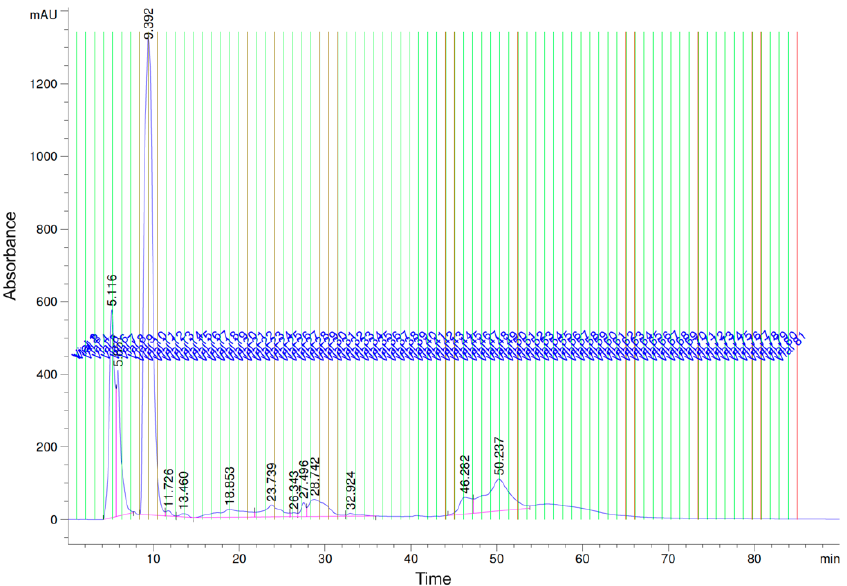
Figure 1. Saliva was collected from female Ae. aegypti after blood feeding. Mosquito saliva was fractionated by high-performance liquid chromatography (HPLC) on a nonporous reverse-phase column with a TFA buffer system into 80 fractions of 100 μ L each.